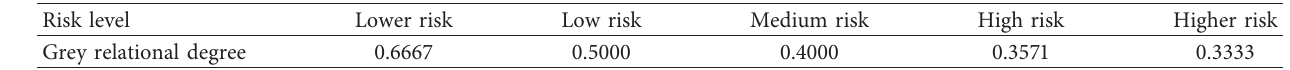
Table 10: Comprehensive grey relational degree.